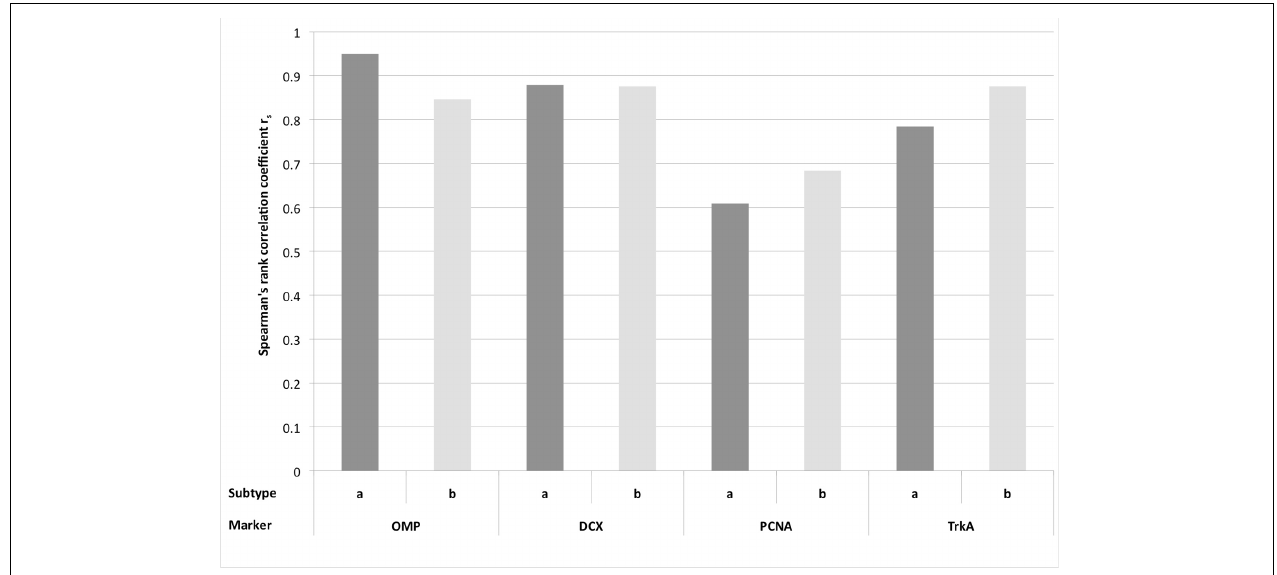
FIGURE 8 | Spearman’s rank correlation coefficient r s for the expression of the immunohistological markers OMP, DCX, PCNA, and TrkA for the subtypes a and b of the olfactory